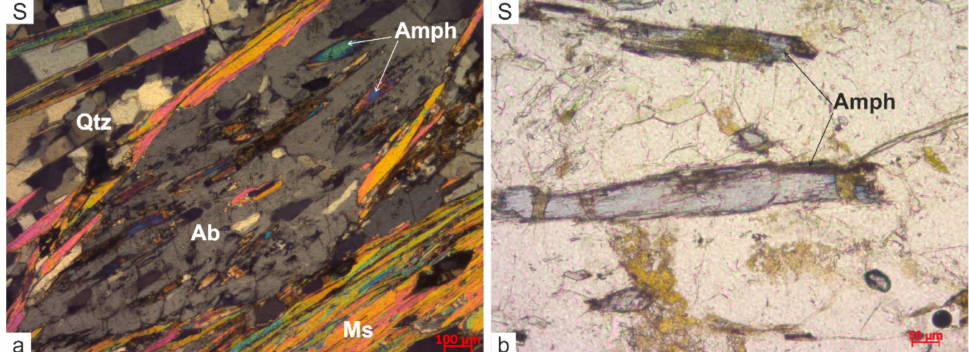
Figure 4. Microphotographs of glaucophane from the Upper Schist Fm. of SW Iraklia. ( a ). Albite por- phyroblast with blue amphibole inclusions (crossed polars), and ( b ). elongated blue-amphibole grains boudinaged during the main D2 deformation stage. Note the chlorite grown in the interboudin